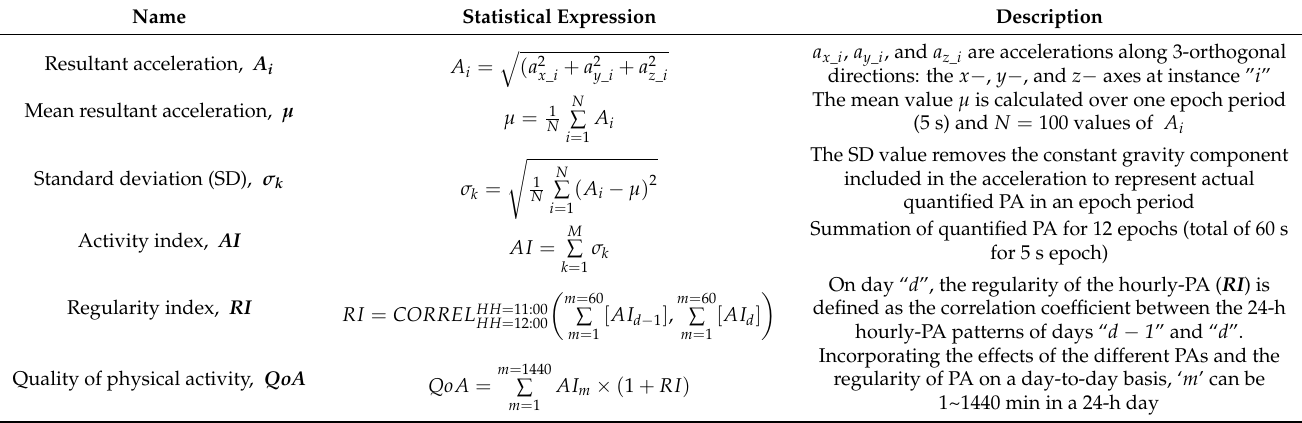
Table 1. Conceptualized activity-based parameters in this